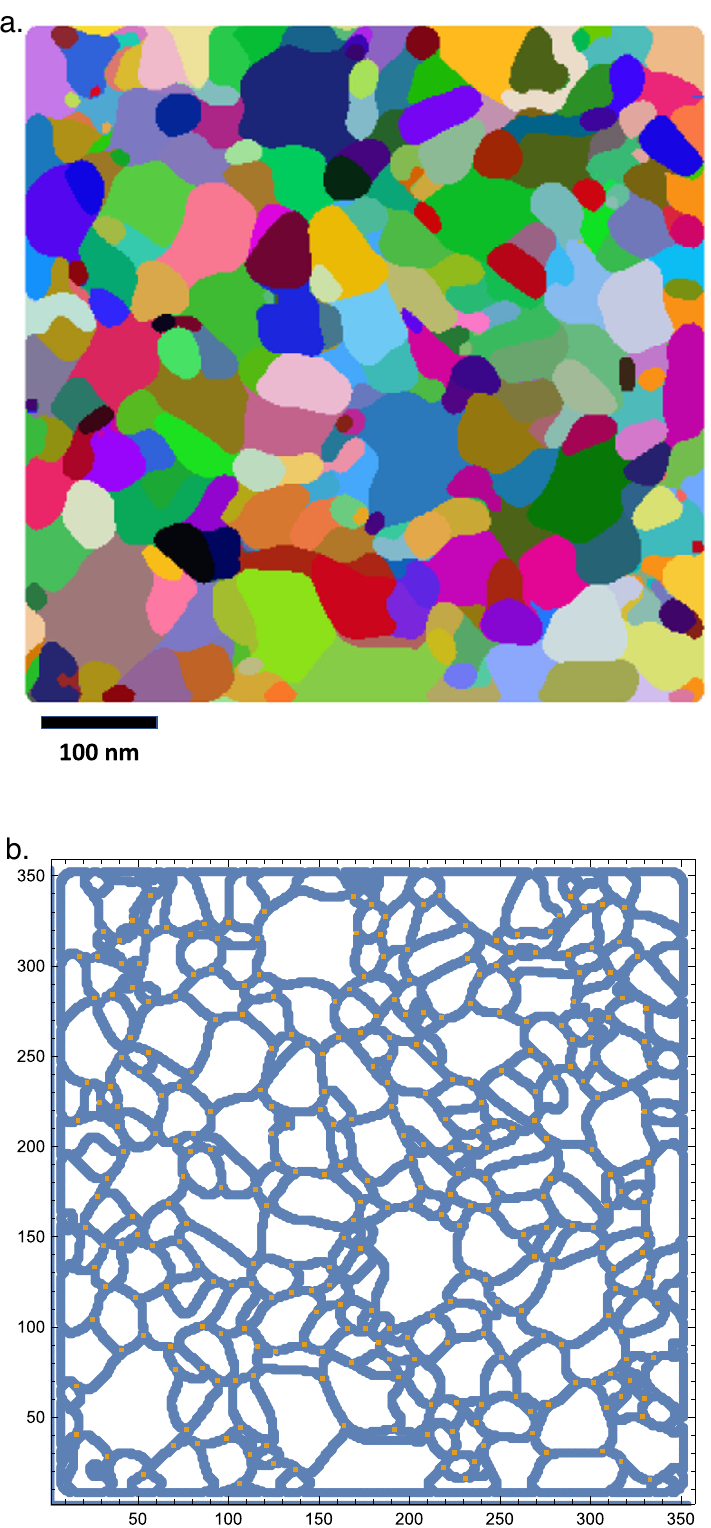
Fig. 1 The microstructure for an Al fi lm. a A representative microstructure for an Al fi lm that was annealed for 150 min at a temperature T = 400 °C. Grain colors re fl ect crystallographic orientations. b An automated trace of the grain boundaries and triple junctions corresponding to the microstructure shown in part a